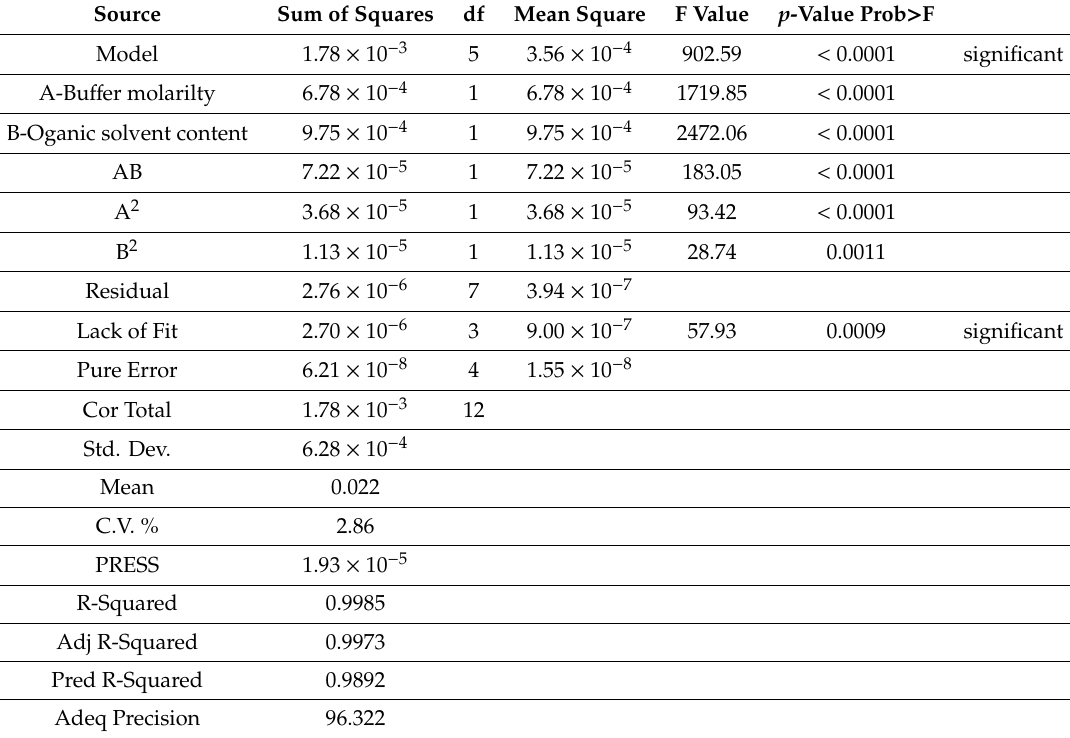
Figure 5. Box-Cox plot for power transformation for retention time following transformation. Table 2. ANOVA table for response surface quadratic model for retention time.